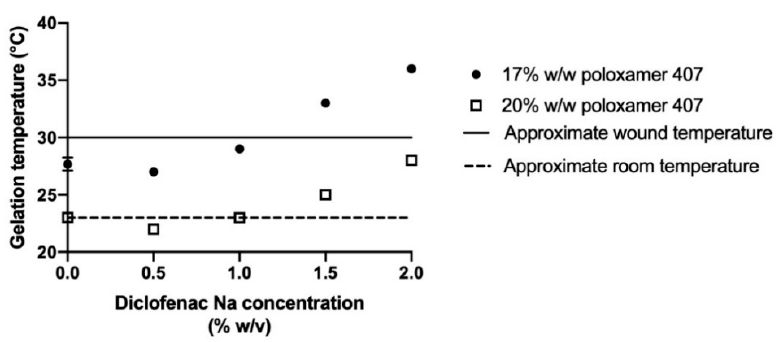
Figure 4. Gelation temperatures for 17% (circles) or 20% w/w (open squares) poloxamer 407 solutions containing between 0% and 2% w/v diclofenac sodium. The dashed line represents approximate room temperature of 23 °C, which was chosen as the minimum preferred gelation temperature to prevent premature gelation. The solid line represents approximate minimum wound temperature of 30 °C [34]. Data are presented as mean ± SD ( n = 3). Error bars for most conditions are too small to be seen in the figure.